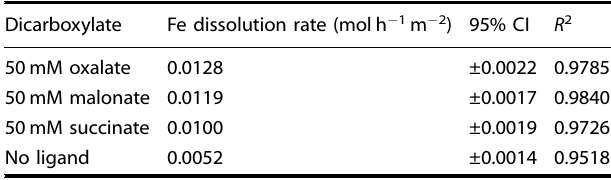
Fig. 1 Total dissolved iron concentration in abiotic corrosion experiments amended with dicarboxylates. Error bars represent standard deviations (too small to be noticeable in the fi gure) of triplicate measurements. Experiments were carried out under anoxic and dark conditions, at circumneutral pH, and 30 °C. Table 2. Zero-order Fe dissolution rates in experiments with oxidized carbon steel and